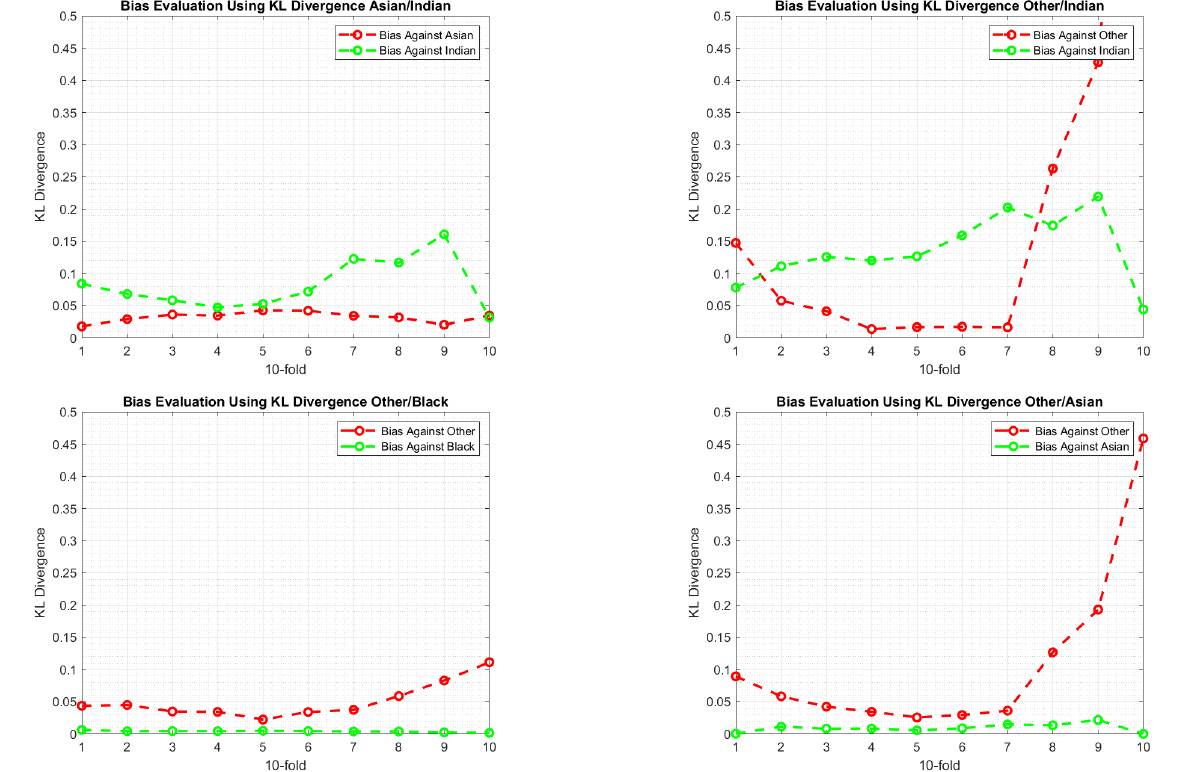
Figure 7. Bias evaluation between different races using